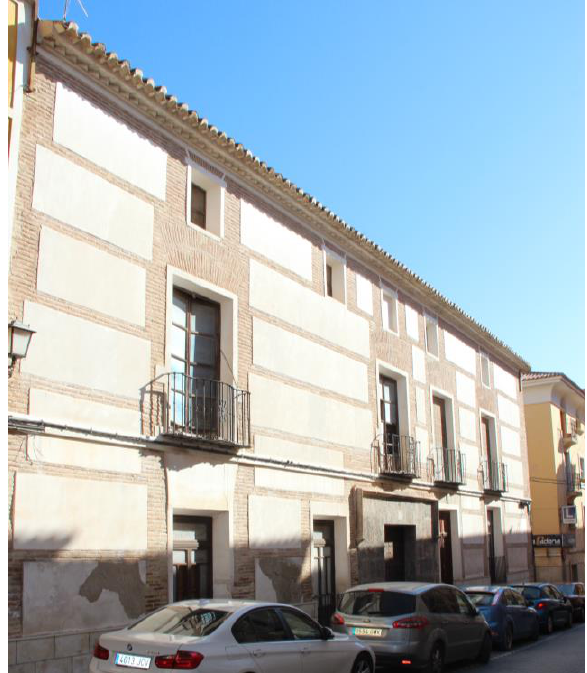
Figure 5. 18th-century palace in Mula (Source: